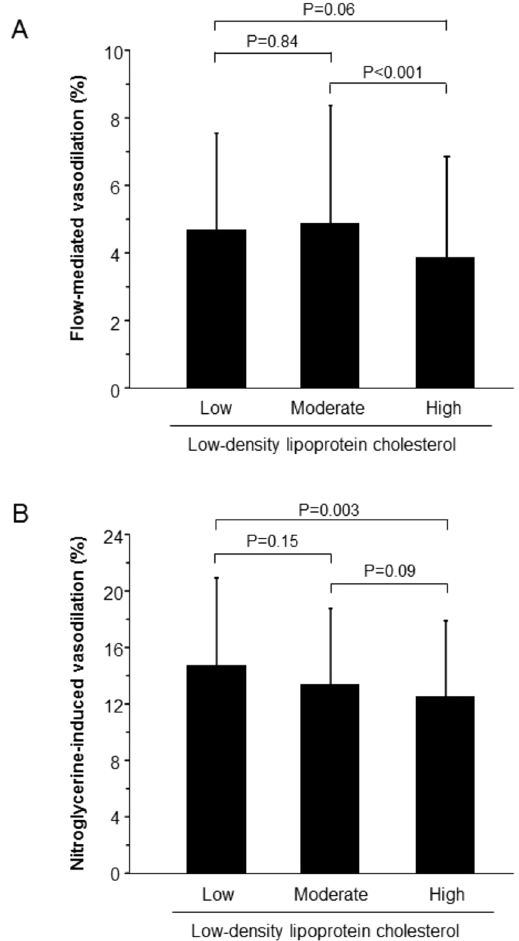
Figure 4. Bar graphs show flow-mediated vasodilation ( A ) and nitroglycerine-induced vasodilation ( B ) in the low, moderate and high low-density lipoprotein cholesterol group.